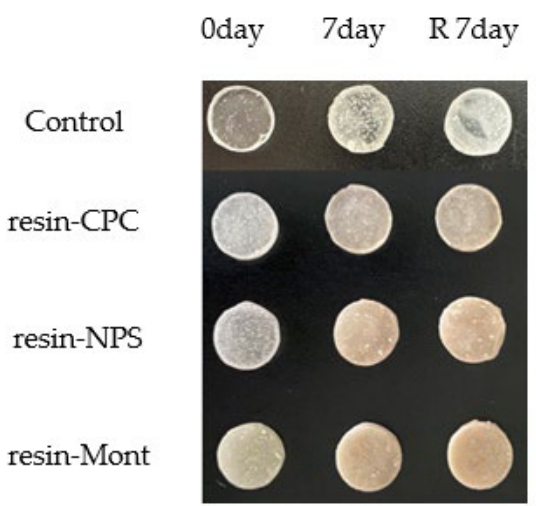
Figure 6. Change in color tone (“after reuptake” is denoted by “R”).